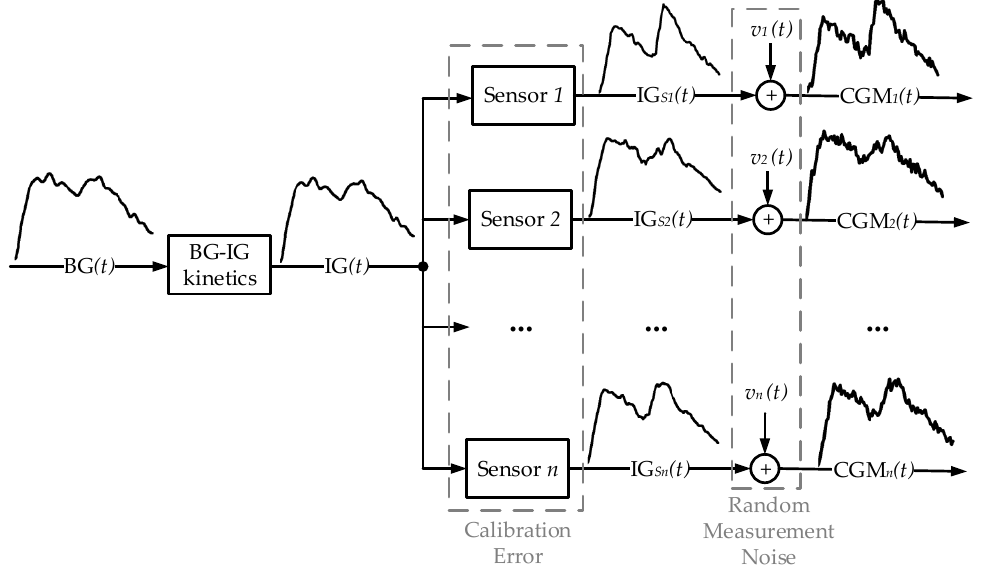
Figure 2. Description of how n parallel CGM signals are modeled. From left to right: transformation of the blood glucose (BG) signal into the interstitium glucose (IG) signal (BG-IG kinetics). Then, each of the n CGM sensors measures the IG signal, generating the IG Si profile, which is susceptible to calibration error. Finally, the measured CGM i is subject to random measurement noise, v i